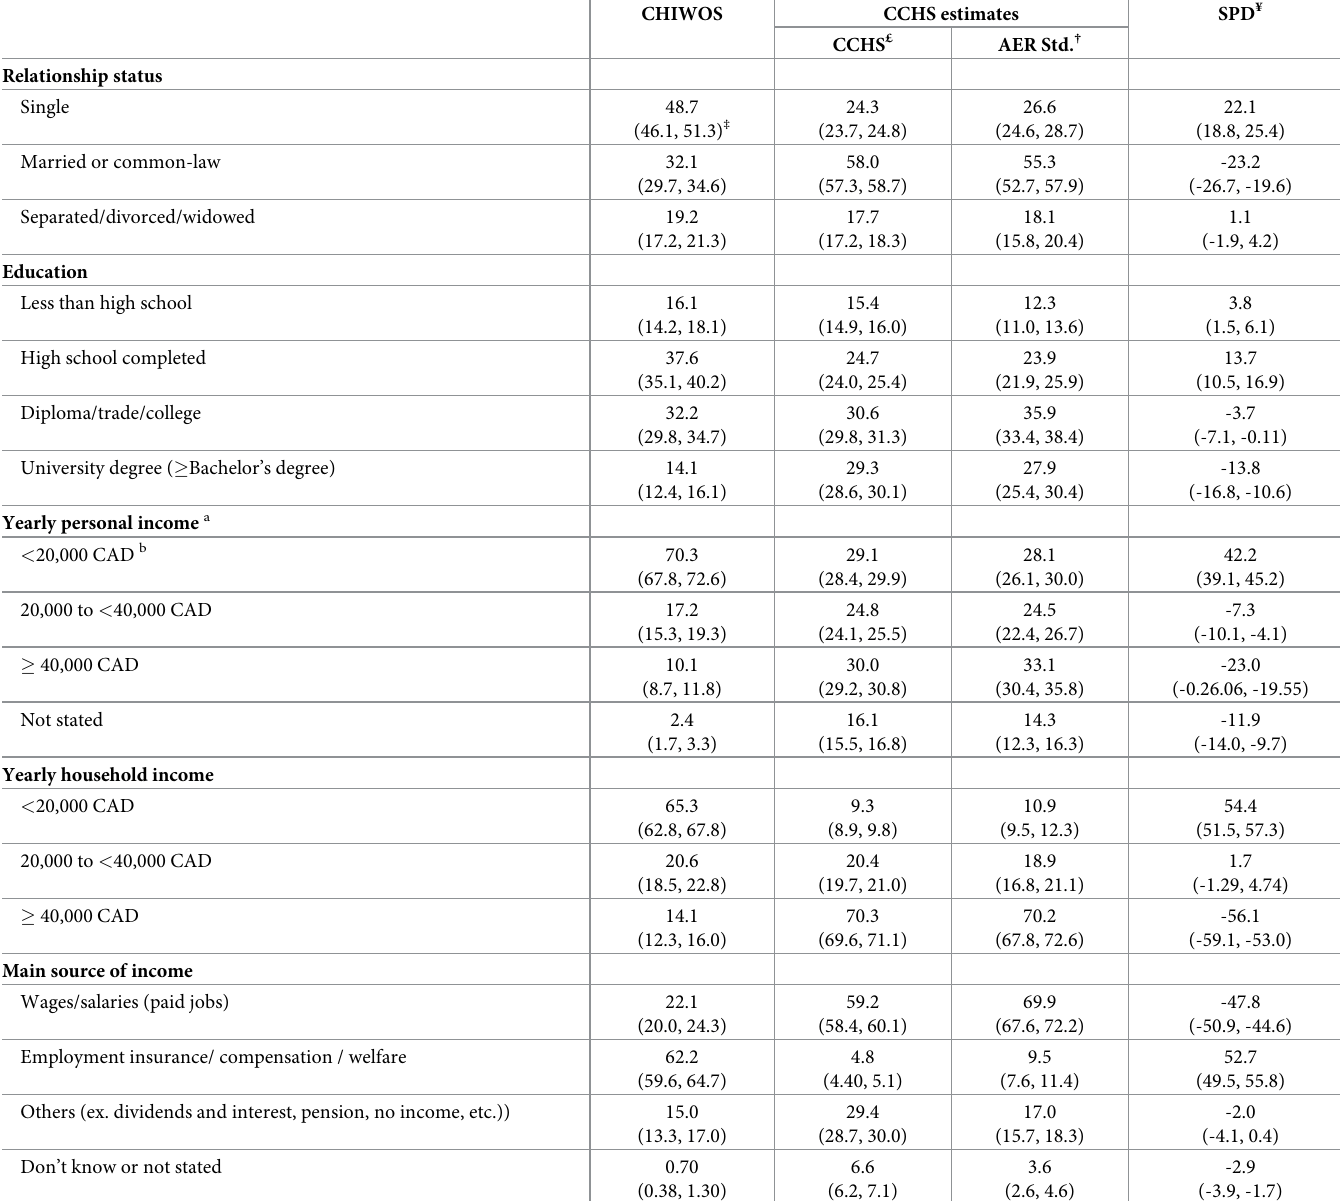
Table 1. Comparing sociodemographic variables of women living with HIV (CHIWOS; 2013–2015) and the general population of women in Canada (CCHS; 2013– 2014) �